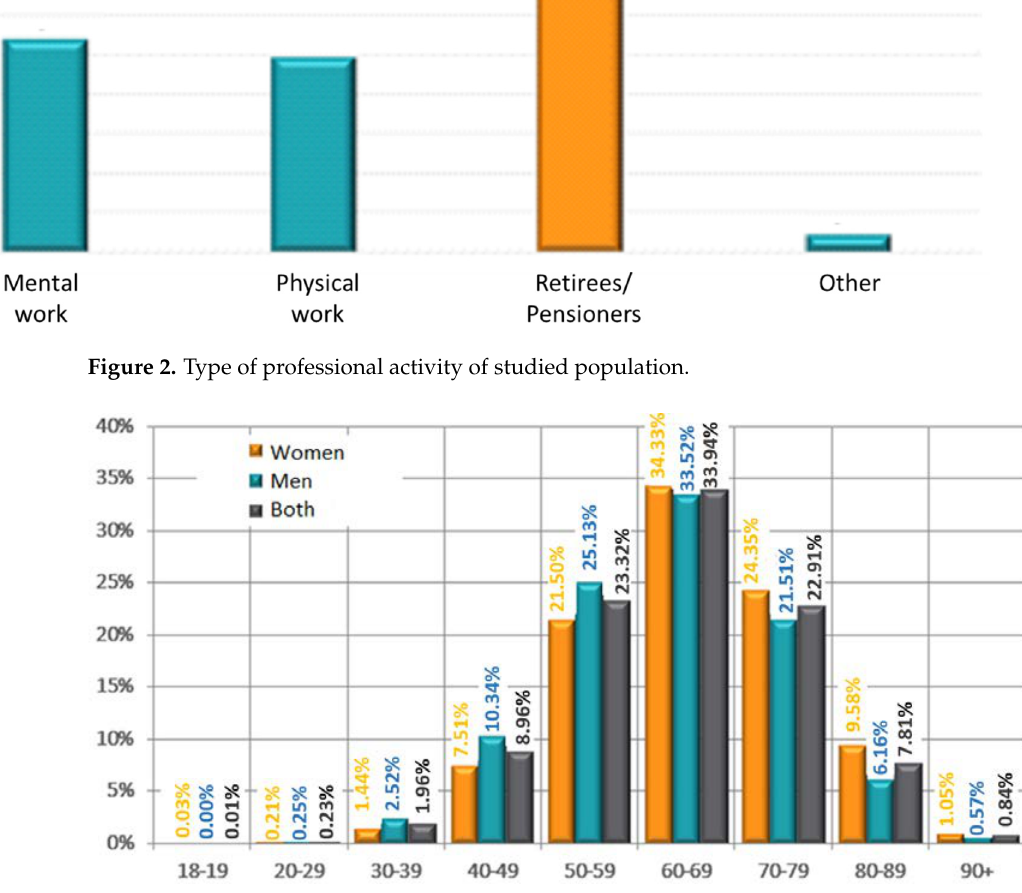
Figure 3. Age groups according to sex.